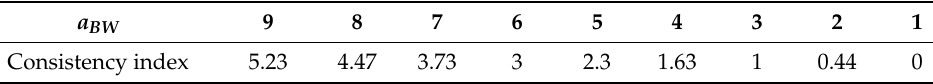
Table 4. Consistency criteria applying BWM method. a BW